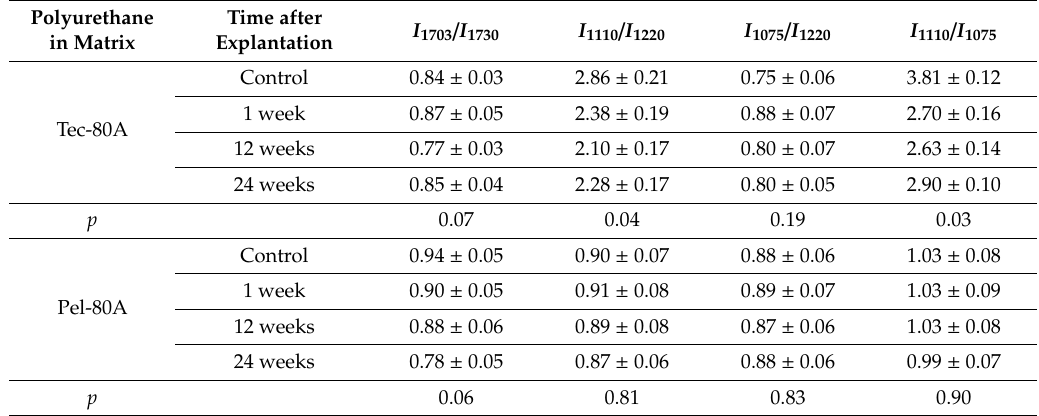
Table 2. Dependence of the ratio of absorption band intensities in the IR Fourier transform spectra of polyurethanes on the time of vascular graft functioning in infrarenal position. Polyurethane Time after in Matrix